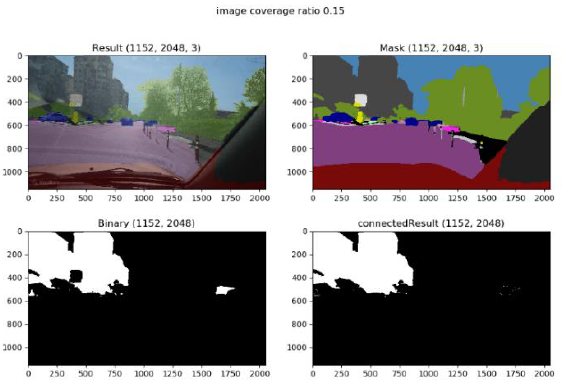
Figure 20. Calculation of incorrect coverage ratio of 0.15 instead of 0. (Image key: Figure 18. Final coverage accepted images with 20% coverage threshold and locations of coverage accepted images relative to target building 5